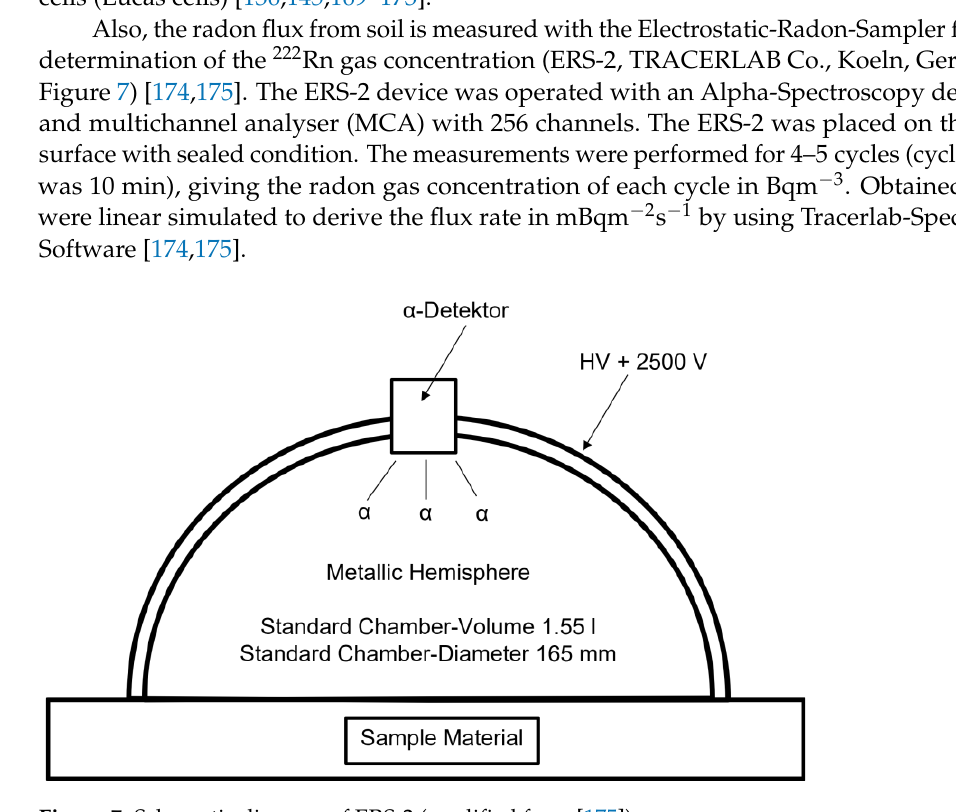
Figure 7. Schematic diagram of ERS-2 (modified from [175]).